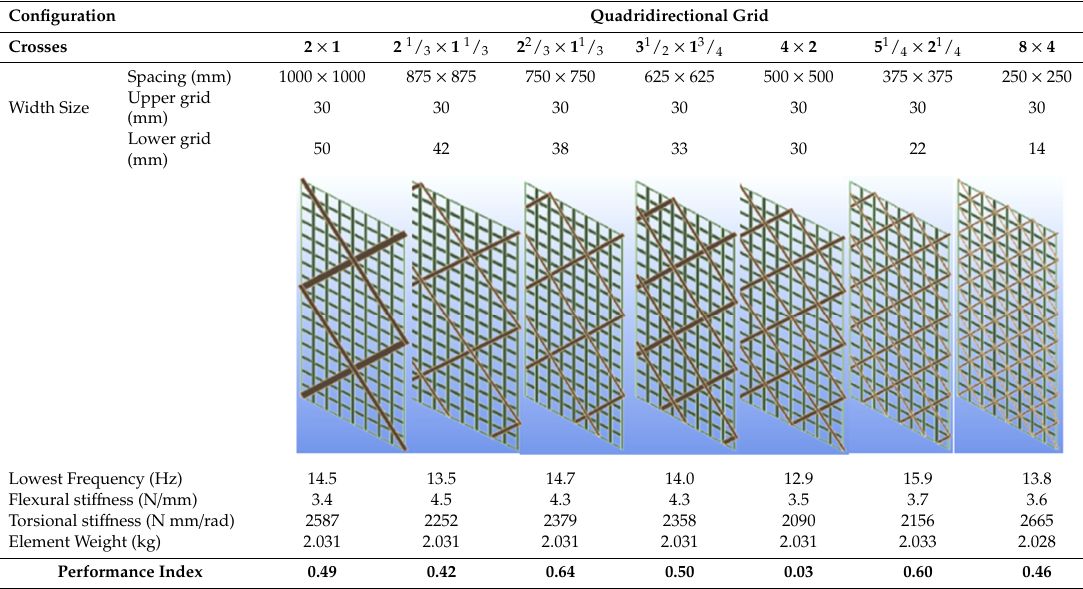
Table 7. Effect of changes in grid shape (at the level of